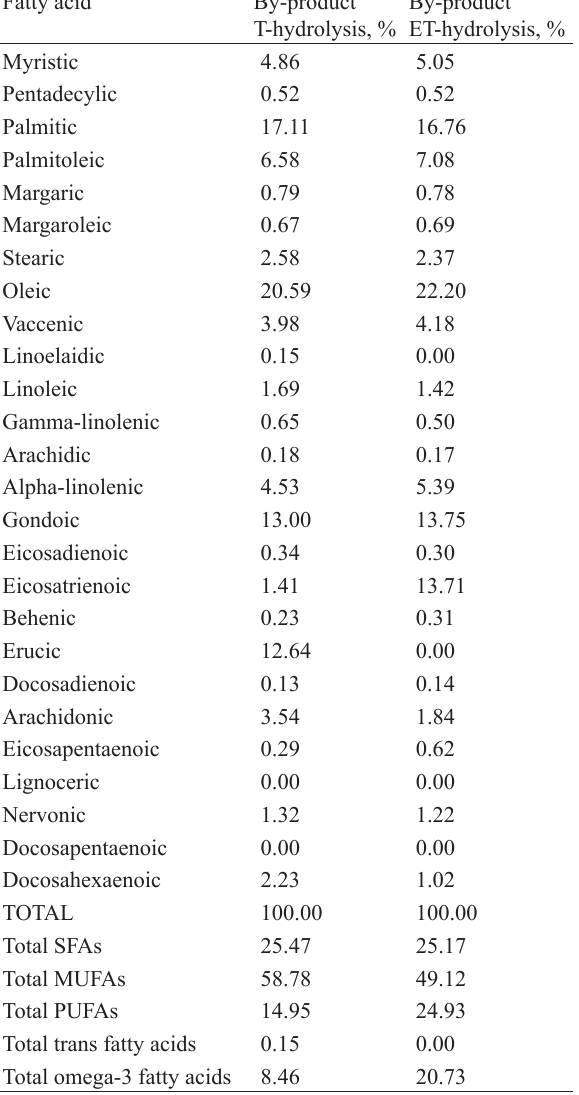
heads. Table 9 represents fractional composition of fatty acids in by-products after T- and ET-hydrolysis.